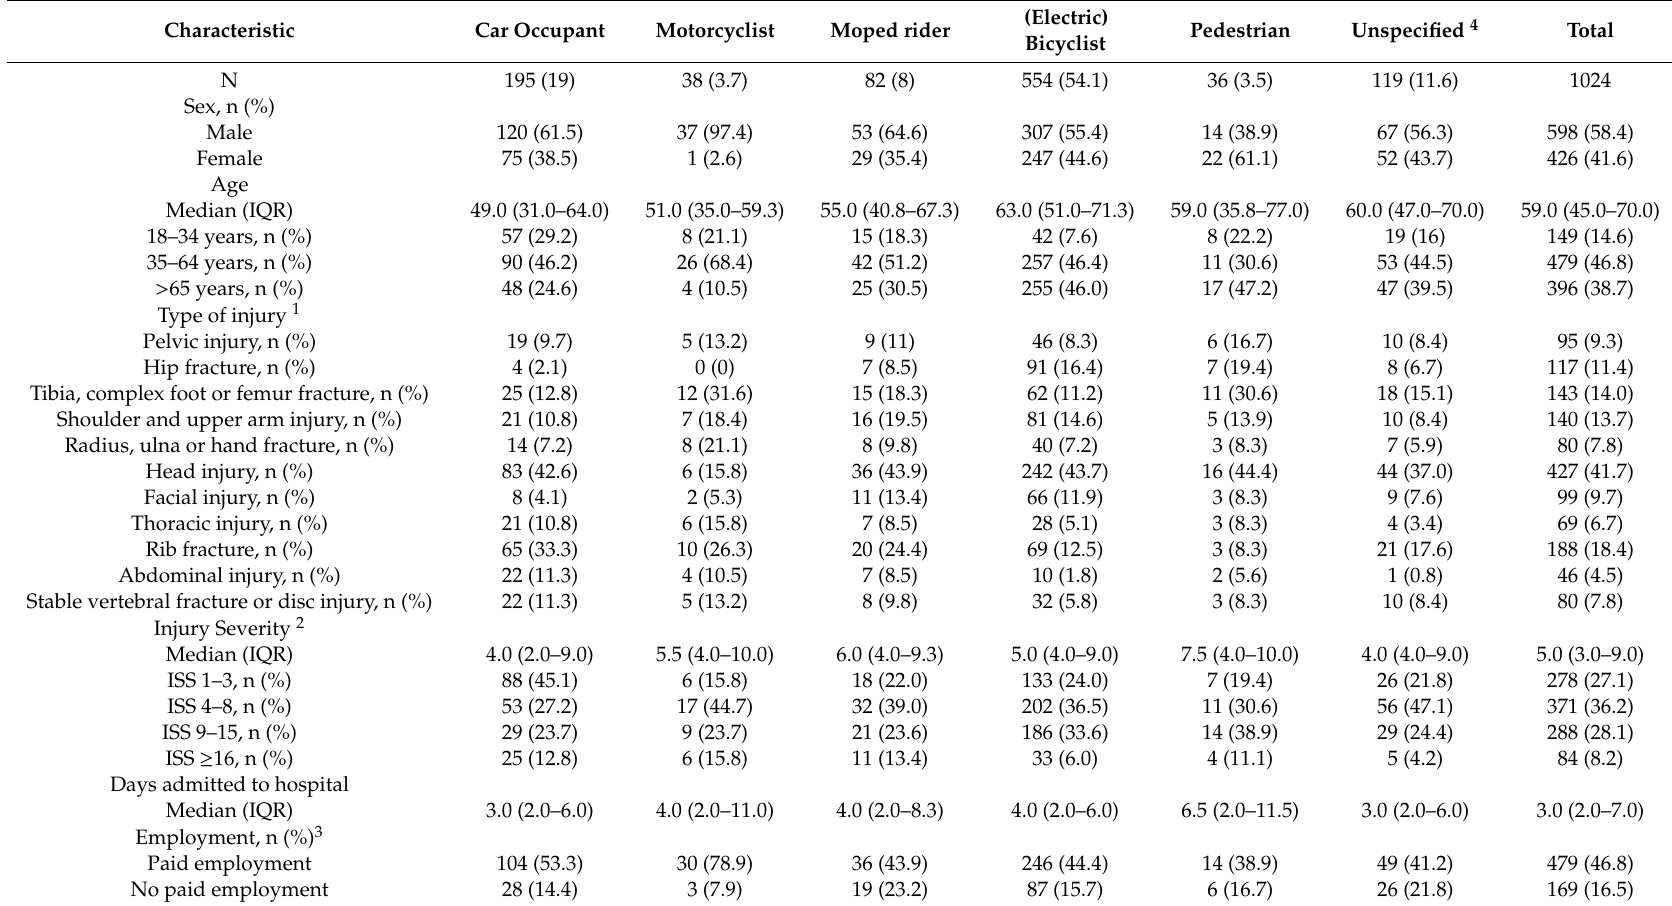
Table 1. Characteristics by road tra ffi c